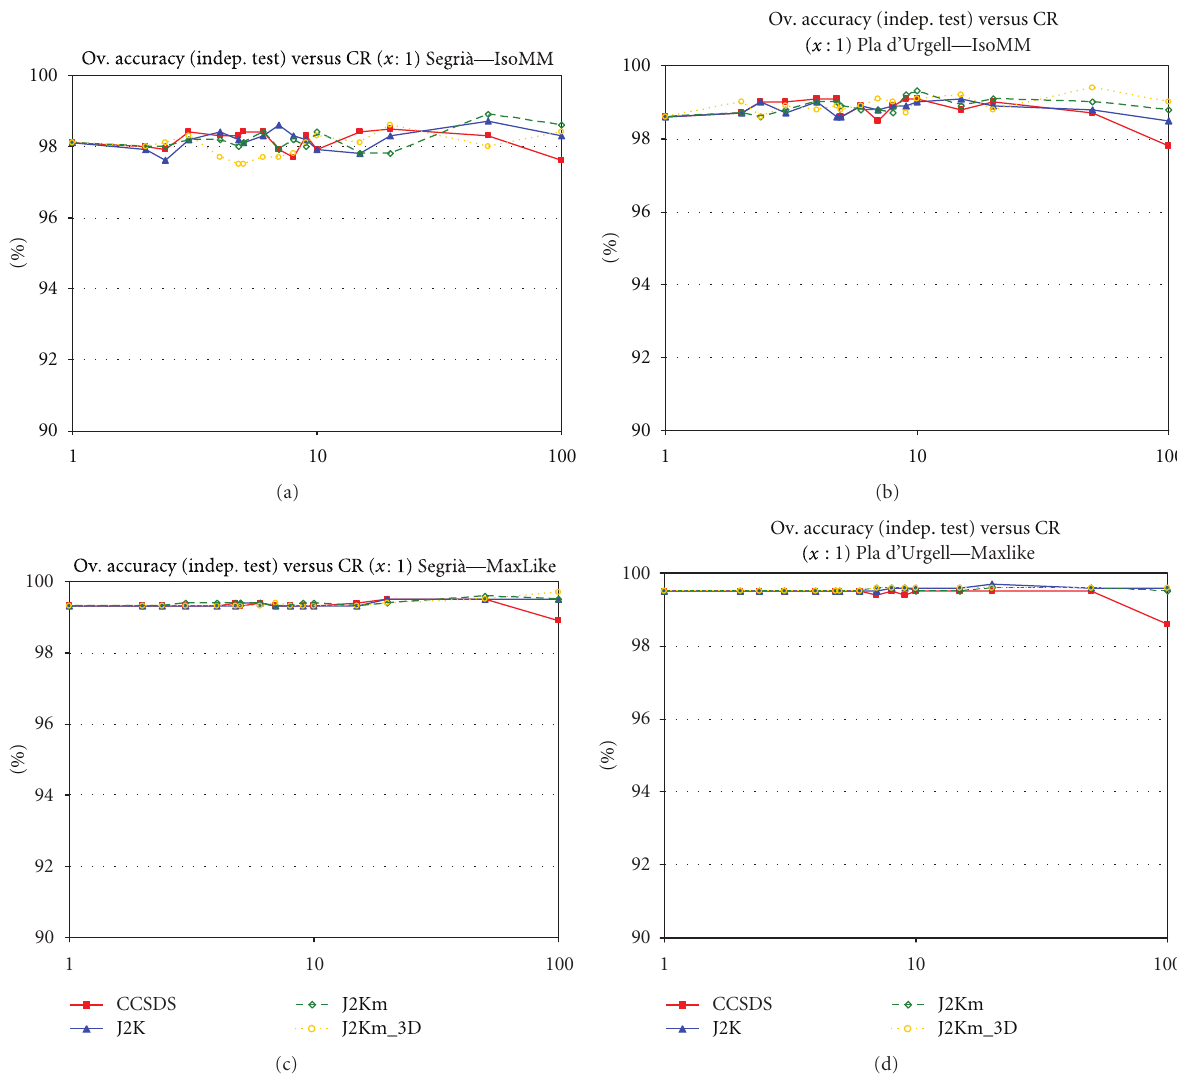
Figure 8: Overall accuracy (in %) computed using independent test areas in relation to the compression ratio (CR, expressed as x :1, e.g., 5:1). The two study areas, two classifying methods, and four compression scenarios are